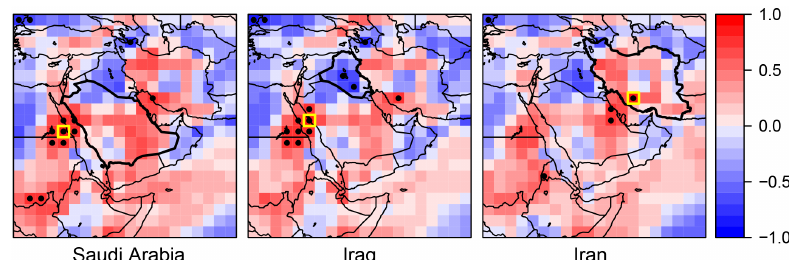
Figure 8. Correlation of surface wind with AOD over Saudi Arabia, Iraq and Iran. For both, wind and AOD, annual averages are used where the averaging period starts with the enhanced AOD season on 1 December. Pixels with significant correlation ( p value < 0.01) are marked with a dot. Pixels with correlation coefficients above 0.8 are outlined in yellow. MODIS Terra collection 6 combined Dark Target/Deep Blue 550nm AOD data are used, for the surface wind we use the ERA-Interim wind at 10m